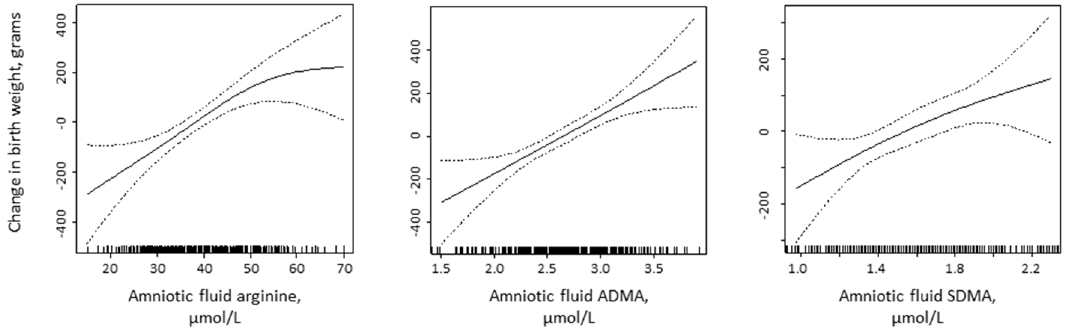
Figure 2. Changes in birth weight in relation to arginine, ADMA, and SDMA concentrations in the amniotic fluid from gestational weeks 13–15 by generalized additive models (GAM).